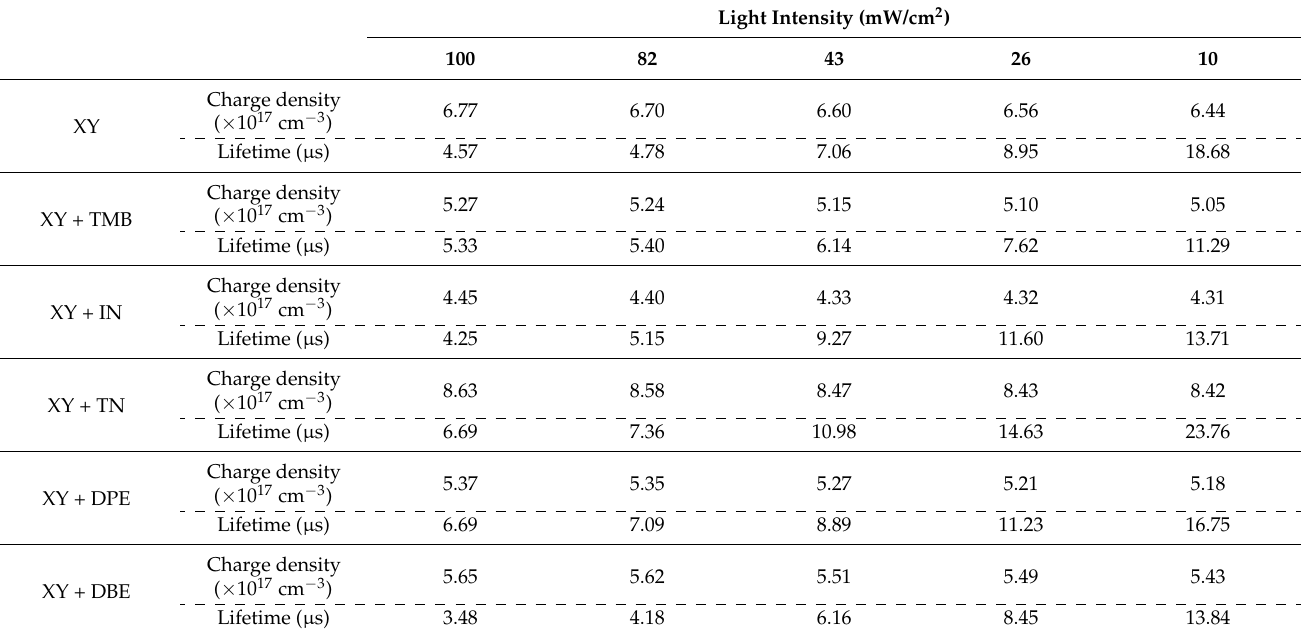
Table 2. Summary of charge density and charge lifetime depending on solvent system and light intensity.